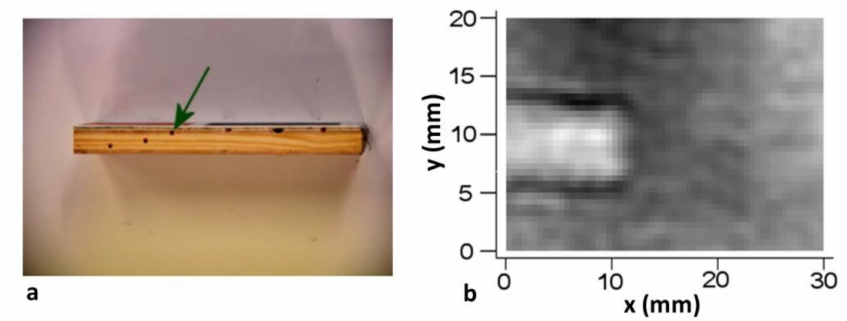
Figure 11. ( a ) Panel painting mock-up with holes (side view); ( b ) THz scan over the hole indicated by the arrow (top